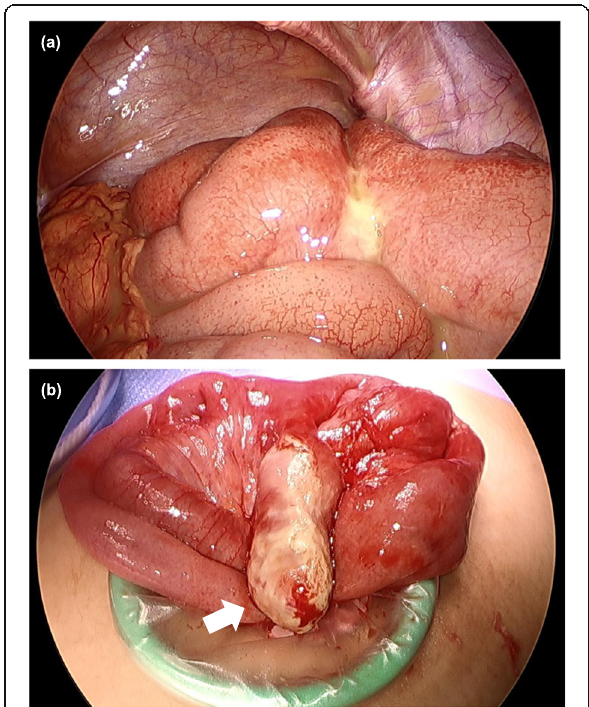
Fig. 3 Intraoperative findings. a A small amount of turbid ascites was found in the abdominal cavity. b Surgical appearance of Meckel ’ s diverticulum (arrow) approximately 30 cm proximal to the ileocecal valve